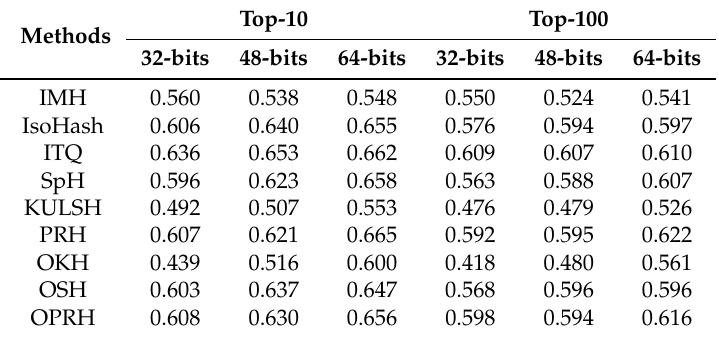
Table 1. The comparison of mean precision of the top K returned examples for different methods on the SAT-4 dataset with varied hash bits.